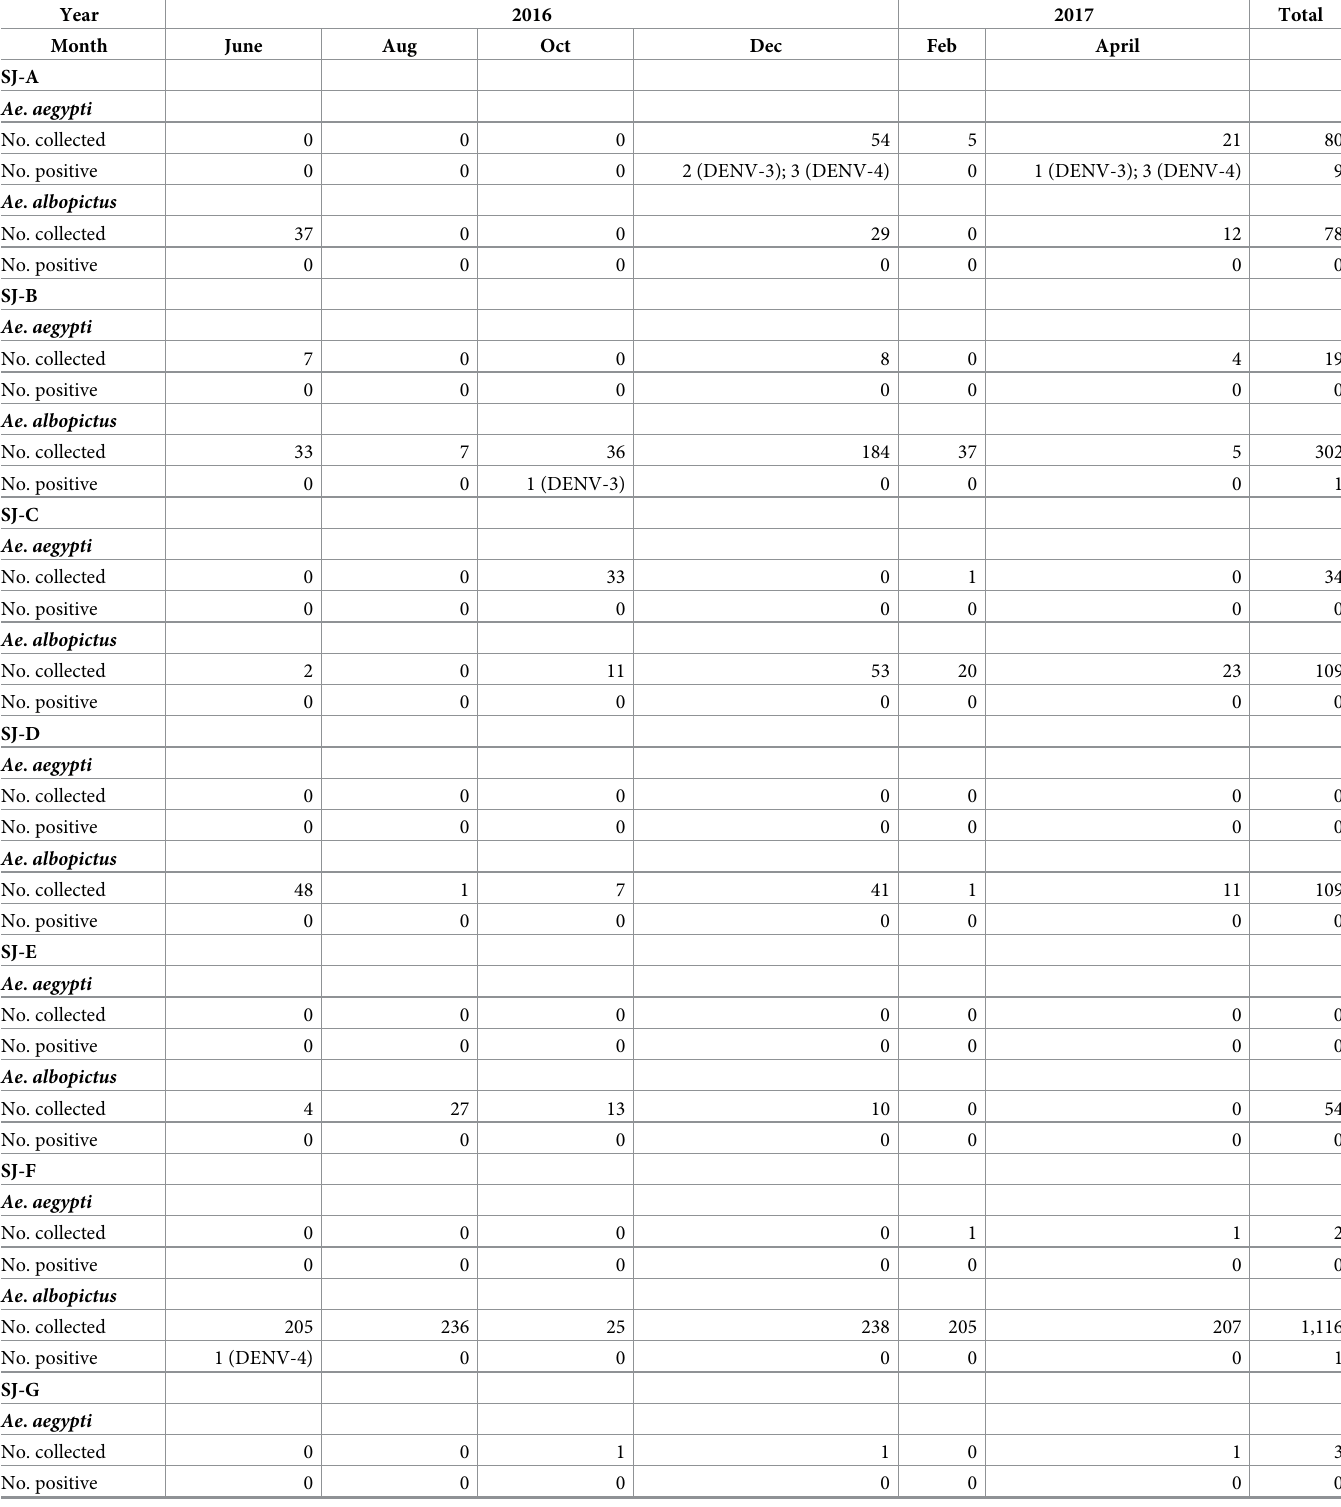
Table 2. DENV detected in Aedes larvae collected in Selangor from June 2016 to April